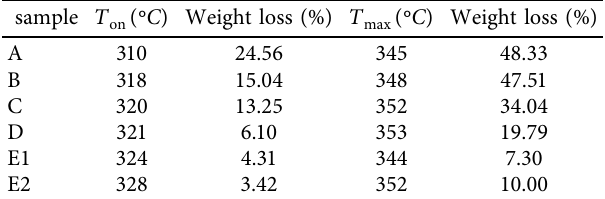
Table 5: (e onset thermal decomposition ( T thermal decomposition ( T DTA